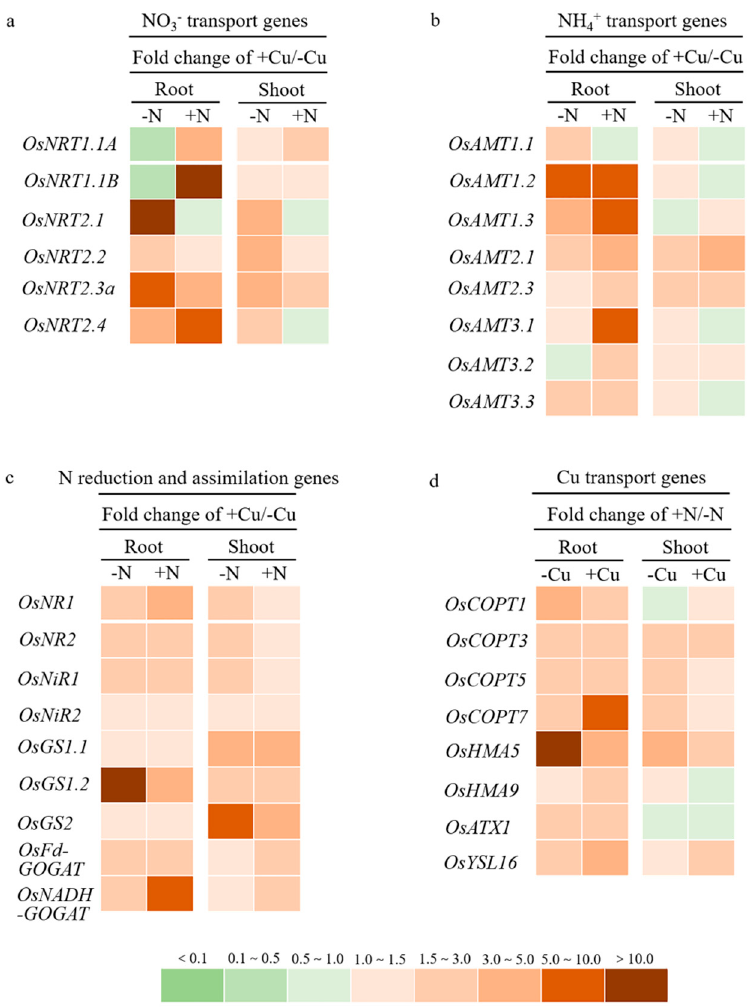
Figure 6. Expression levels of genes involved in NO 3 − transport ( a ), NH 4 + transport ( b ), NO 3 − reduction and NH 4+ assimilation ( c ), and Cu transport ( d ) in the root and shoots of rice plant grown in solutions with different combinations of Cu (-Cu, 0 µ M; +Cu, 0.15 µ M) and N (-N, 0.288 mM; +N, 2.88 mM) supply for three weeks. Data are fold changes of expression levels of N-related genes under +Cu compared to -Cu conditions, or Cu-related genes under +N compared to -N conditions.